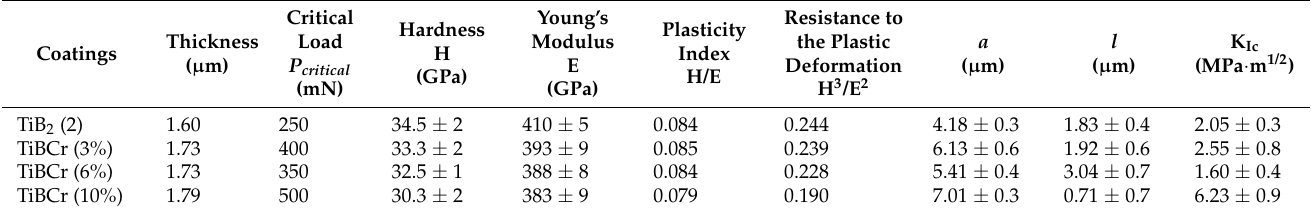
Table 3. The characteristic parameters of thickness, critical load, hardness, Young’s modulus, H/E and H 3 /E 2 for TiB 2 (2) and TiBCr coatings were used for the calculation of the K Ic coefficient by using the Laugier model [22].